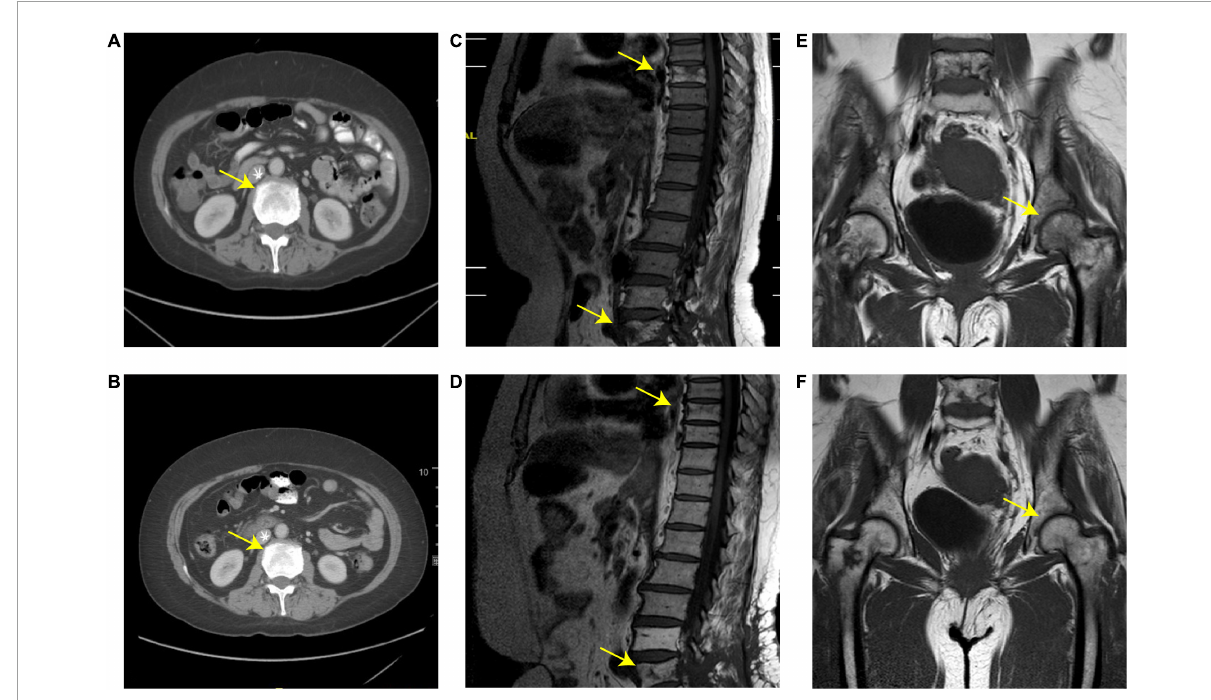
FIGURE1 (A,B) Abdominal computed tomography (CT) scan; (C,D) spine magnetic resonance imaging (MRI); (E,F) MRI of the hip joint before and after treatment. (A,C,E) Skeletal lesions with osteolysis in the femoral head, T8, and L4-L5 before local radiotherapy. (B,D,F) Osteolytic lesions diminished after local radiotherapy and high-dose methotrexate (HD-MTX) treatment. The yellow arrows represent the location of the lesion.